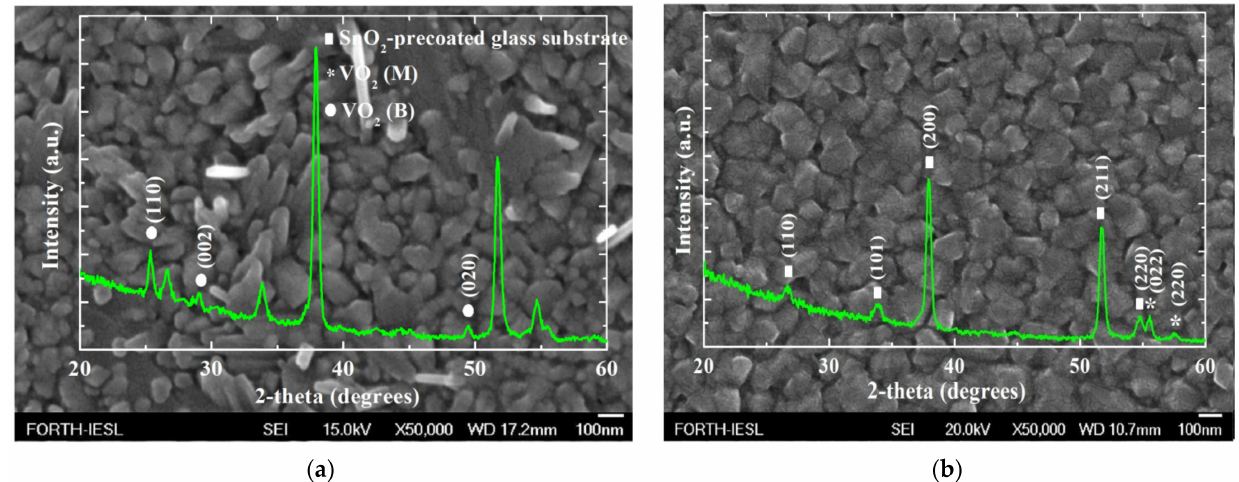
Figure 3. ( a ) X-ray diffraction (XRD) patterns of the APCVD vanadium oxides at 500 ◦ C for 1 L min − 1 and ( b ) 2.2 L min − 1 N 2 flow rate through the VO(acac) 2 bubbler overlapped on FE-SEM images for × 50,000 magnification